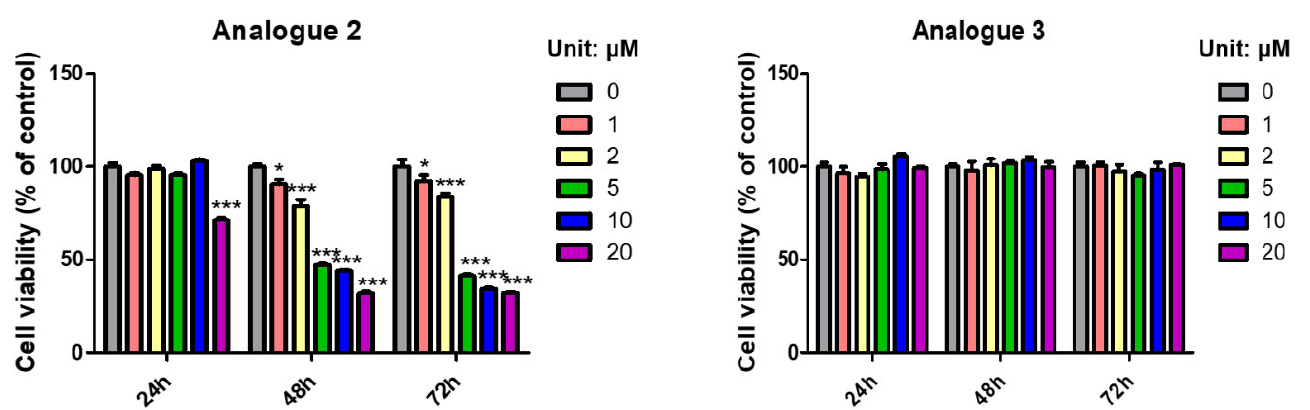
Figure 6. Effects of analogs 2 and 3 on B16F10 cell viability. The effects of treatments with analogs 2 and 3 were determined using the EZ-Cytox assay at 0, 1, 2, 5, 10, or 20 µ M for 24, 48, or 72 h. Optical densities at 450 nm were measured after exposure to EZ-Cytox solution for 2 h. Results are the means ± standard errors of means (SEMs). Experiments were independently conducted in triplicate. The symbol (*) represents significant differences between columns: *** p < 0.001, * p < 0.05 versus non-treated controls.